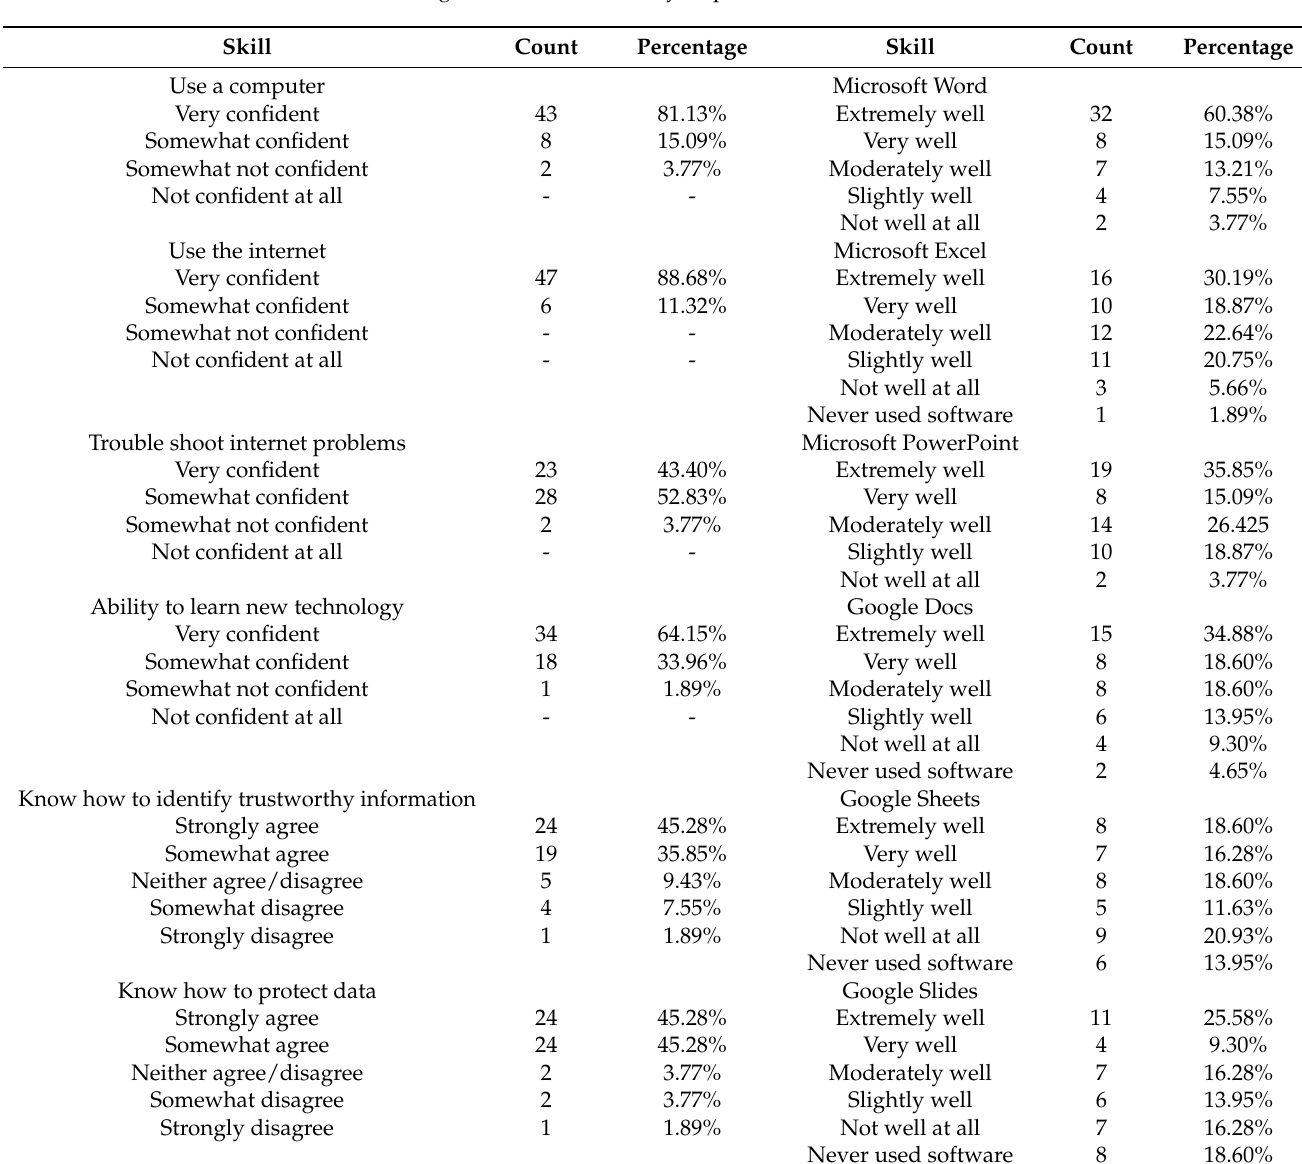
Table 5. Digital identities of survey